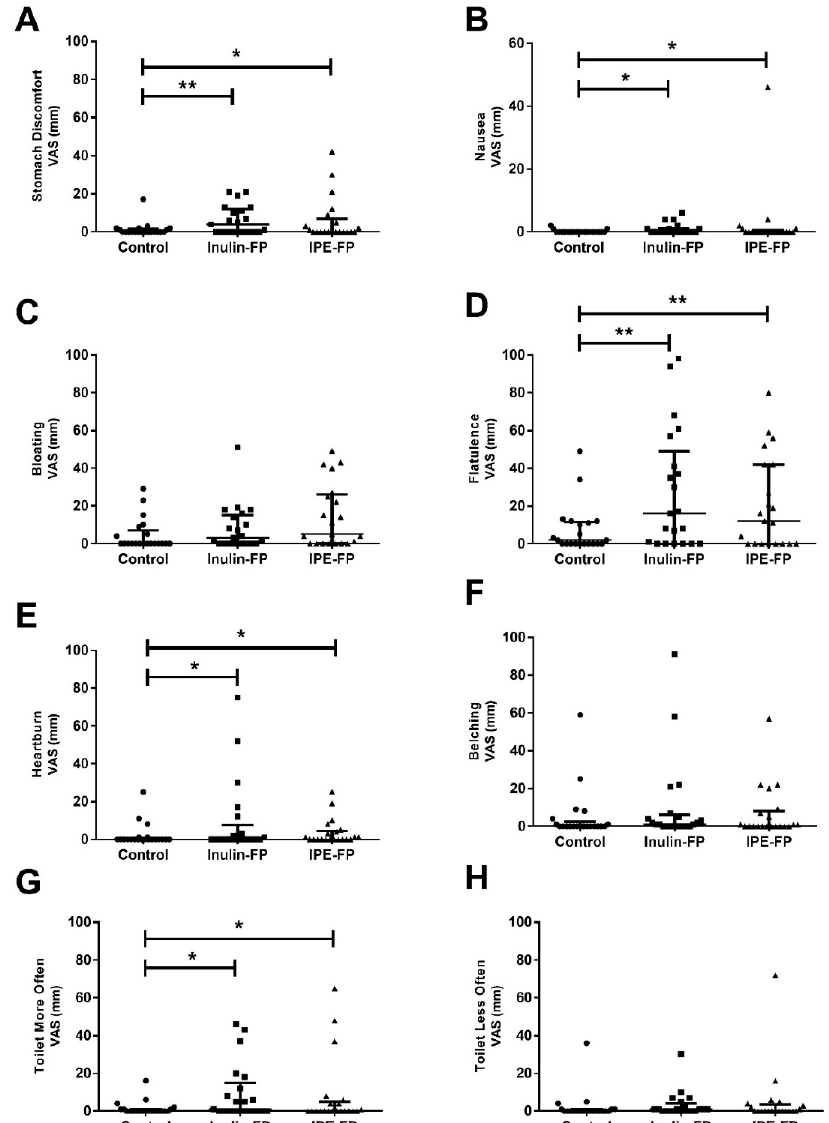
Figure 1. Gastrointestinal side e ff ects following a seven-day supplementation with inulin-FP or IPE-FP compared to control-FP. Data represents median [IQR] gastrointestinal side-e ff ects ratings ( A ) Stomach Discomfort, ( B ) Nausea, ( C ) Bloating, ( D ) Flatulence, ( E ) Heartburn, ( F ) Belching, ( G ) Toilet More